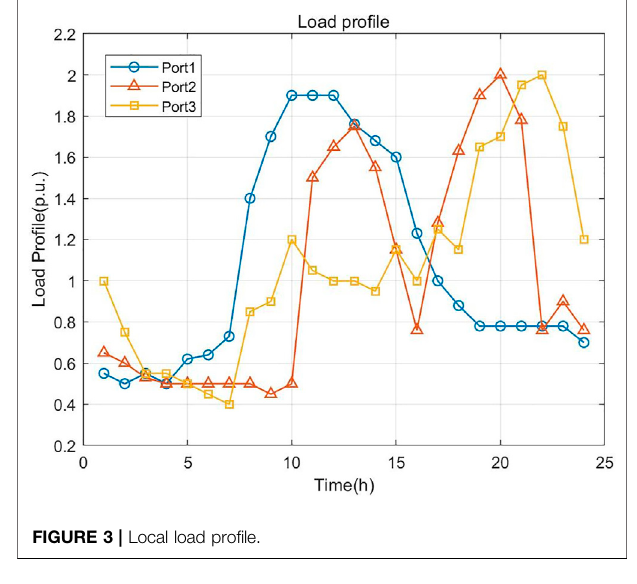
FIGURE 3 | Local load pro fi le.